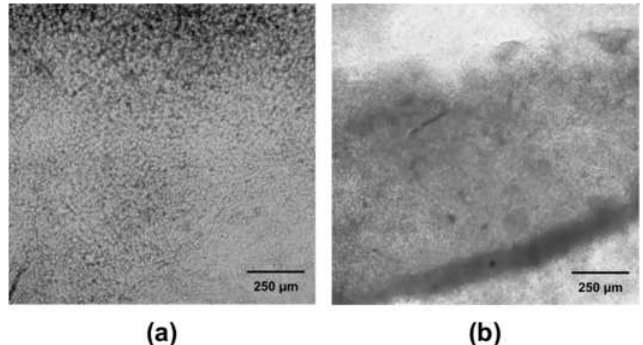
Figure 2. Bright-field micrograph of embryonic chicken cardiomyocytes cultured on a PDMS microscaffold (soft PDMS). ( a ) Cardiomyocytes in a monolayer attached to the center of the ring in the soft PDMS. ( b ) Cardiomyocytes in a monolayer attached to the ring channel.